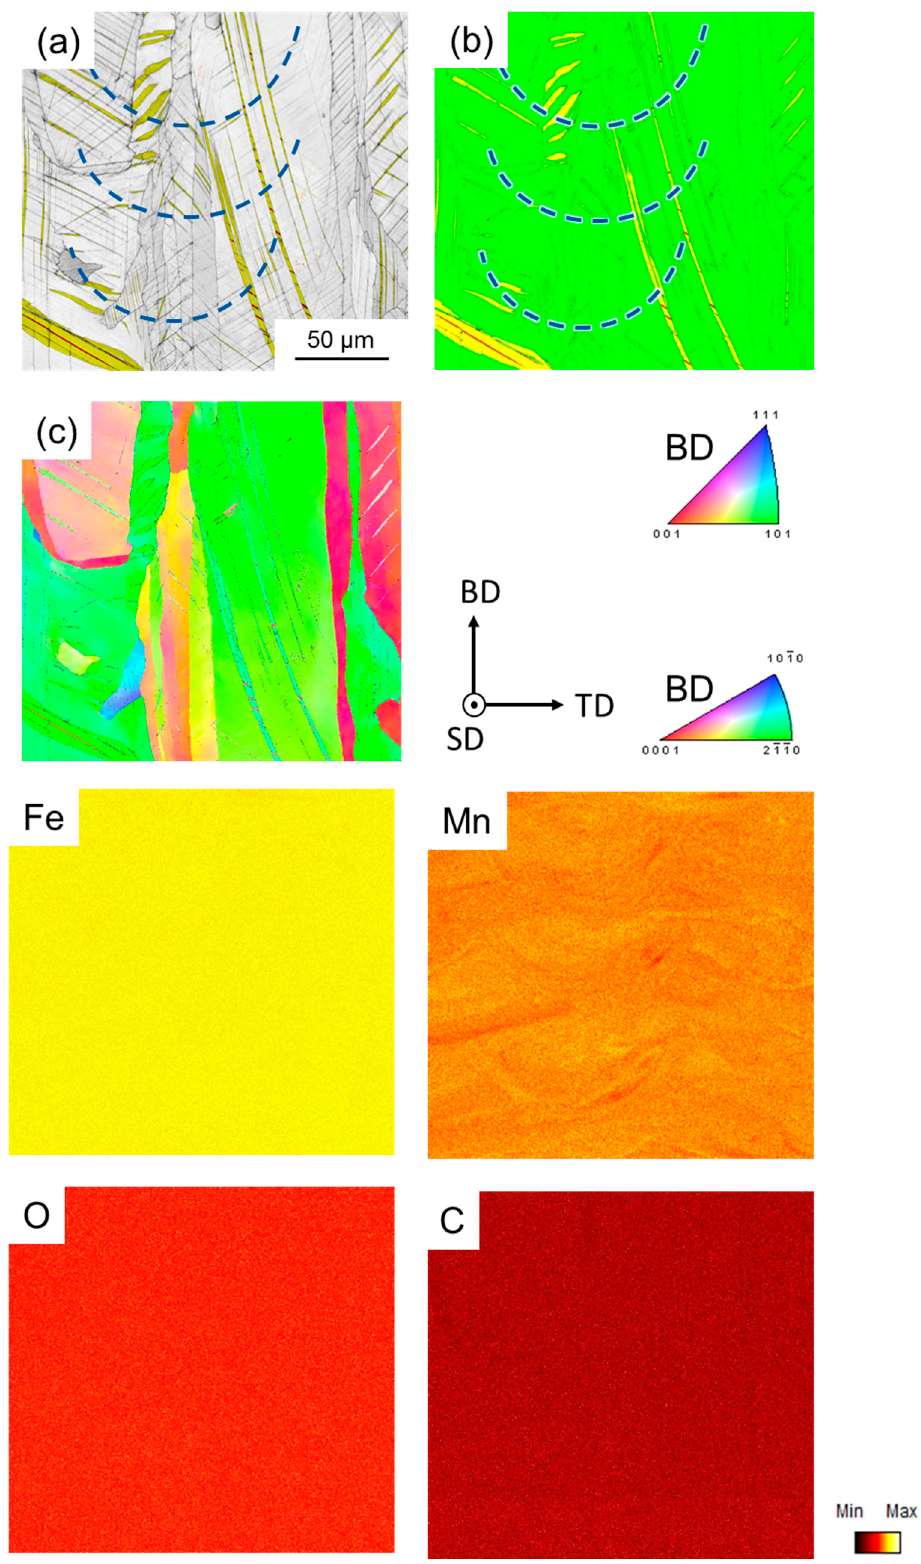
Figure 5. Microstructure of the investigated steel after SLM: ( a ) image quality EBSD map overlain by a phase map only including hexagonal ε -martensite in yellow and tetragonal α ’-martensite in red; ( b ) EBSD map showing the autenite phase in green, hexagonal ε -martensite in yellow, and α ’-martensite in red; ( c ) inverse pole figure EBSD map, and Fe, Mn, O, and C EDX element maps taken from the same area as ( a – c ). The blue dashed lines in ( a , b ) indicate the position of individual laser-melted tracks.